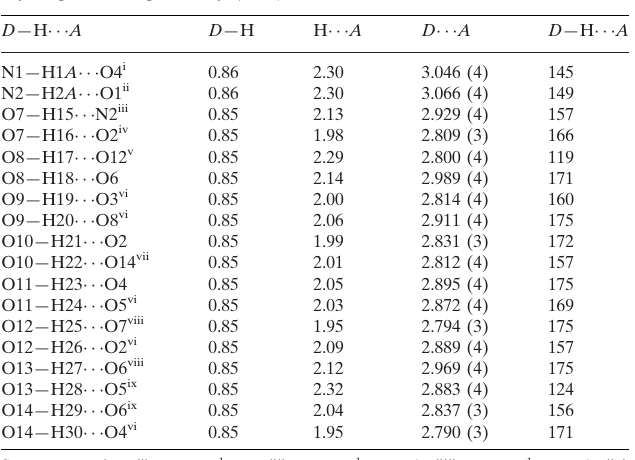
Hydrogen-bond geometry (A˚ , (cid:3)